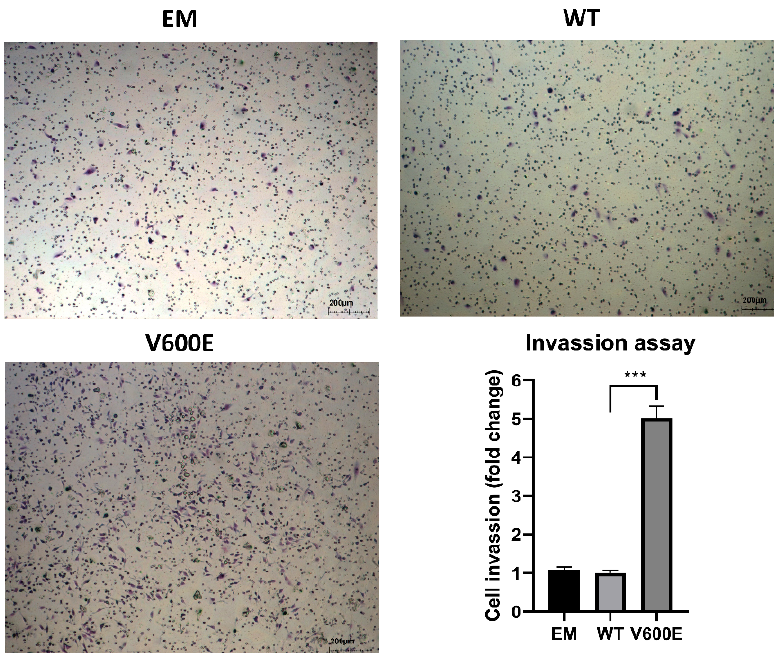
Figure 5. Effect of BRAF V600E overexpression on the THLE-2 cells invasion. THLE-2 cells exhibited augmented invasion capacity after overexpression of BRAF V600E compared with control cells. Quantitative data of invasion assay are presented as the mean ± SD, *** p < 0.001. One-way ANOVA with Bonferroni corrections was applied for statistical analysis.